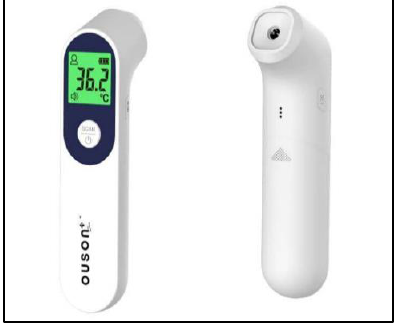
Figure 10. Non-contact thermometer. Table 1. Body temperature